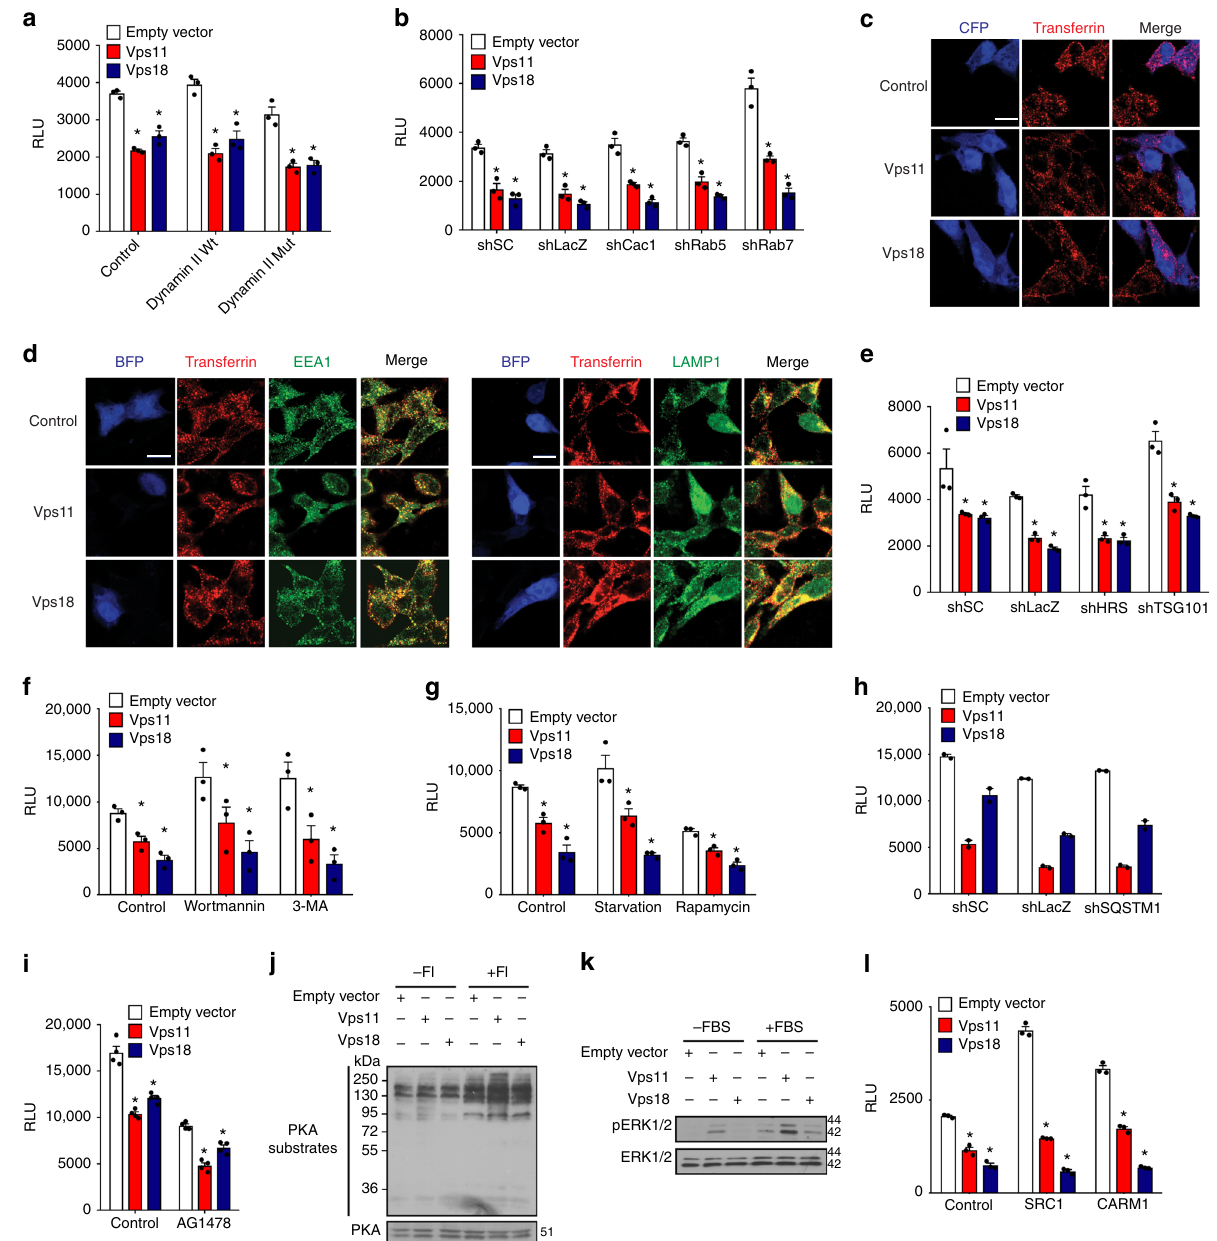
Fig. 4 Regulation of ER α activity by Vps11/18 is independent of intracellular traf fi cking pathways. a ER α reporter gene assays with HEK293T